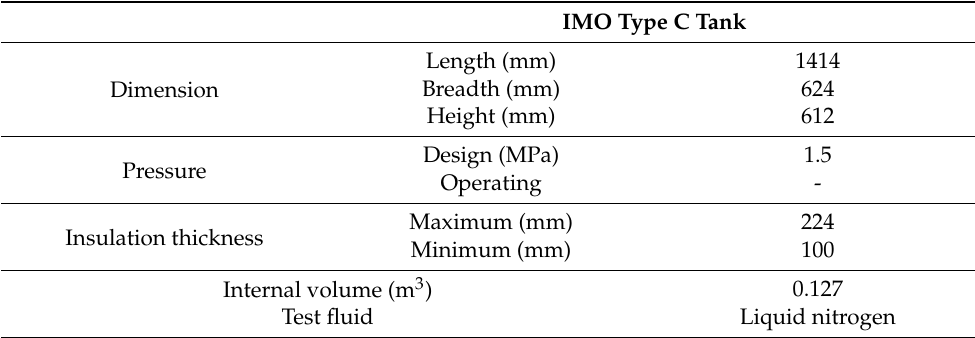
Table 2. Specification for IMO Type C